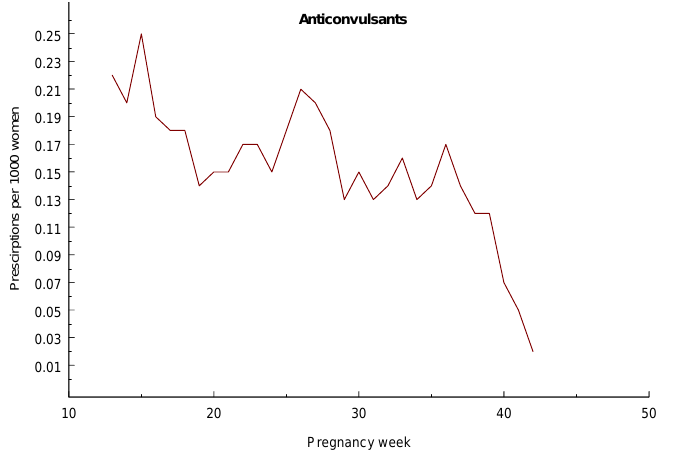
Figure 2. Diagram showing number of women per 1,000 who had filled a prescription for an anticonvulsant for each gestational